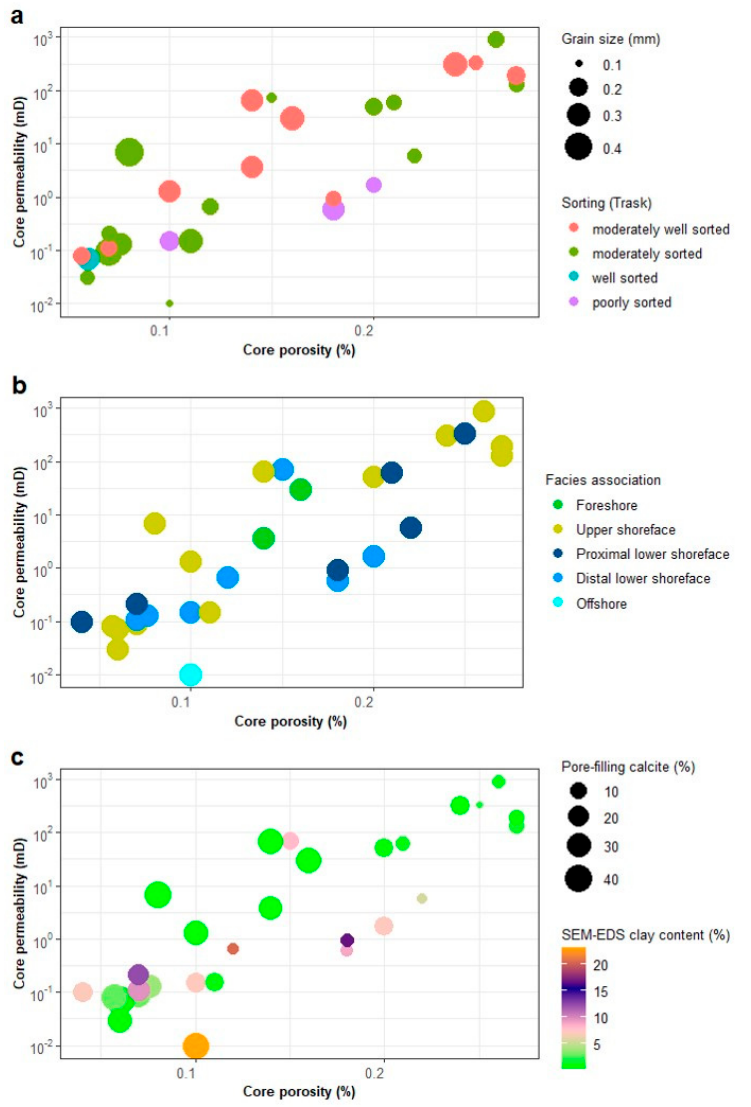
Figure 18. Assessment of the controls on core porosity and permeability for all three wells: ( a ) No clear pattern between grain size and sorting with porosity and permeability ( b ) No clear relationship between porosity and permeability with facies associations as the best reservoir quality is in the upper shoreface and proximal lower shoreface facies associations which also have samples with low porosity and permeability. ( c ) The best reservoir quality zones have low calcite content and clay content. Samples with low calcite content and high clay content have a lower permeability range than samples in their porosity range.